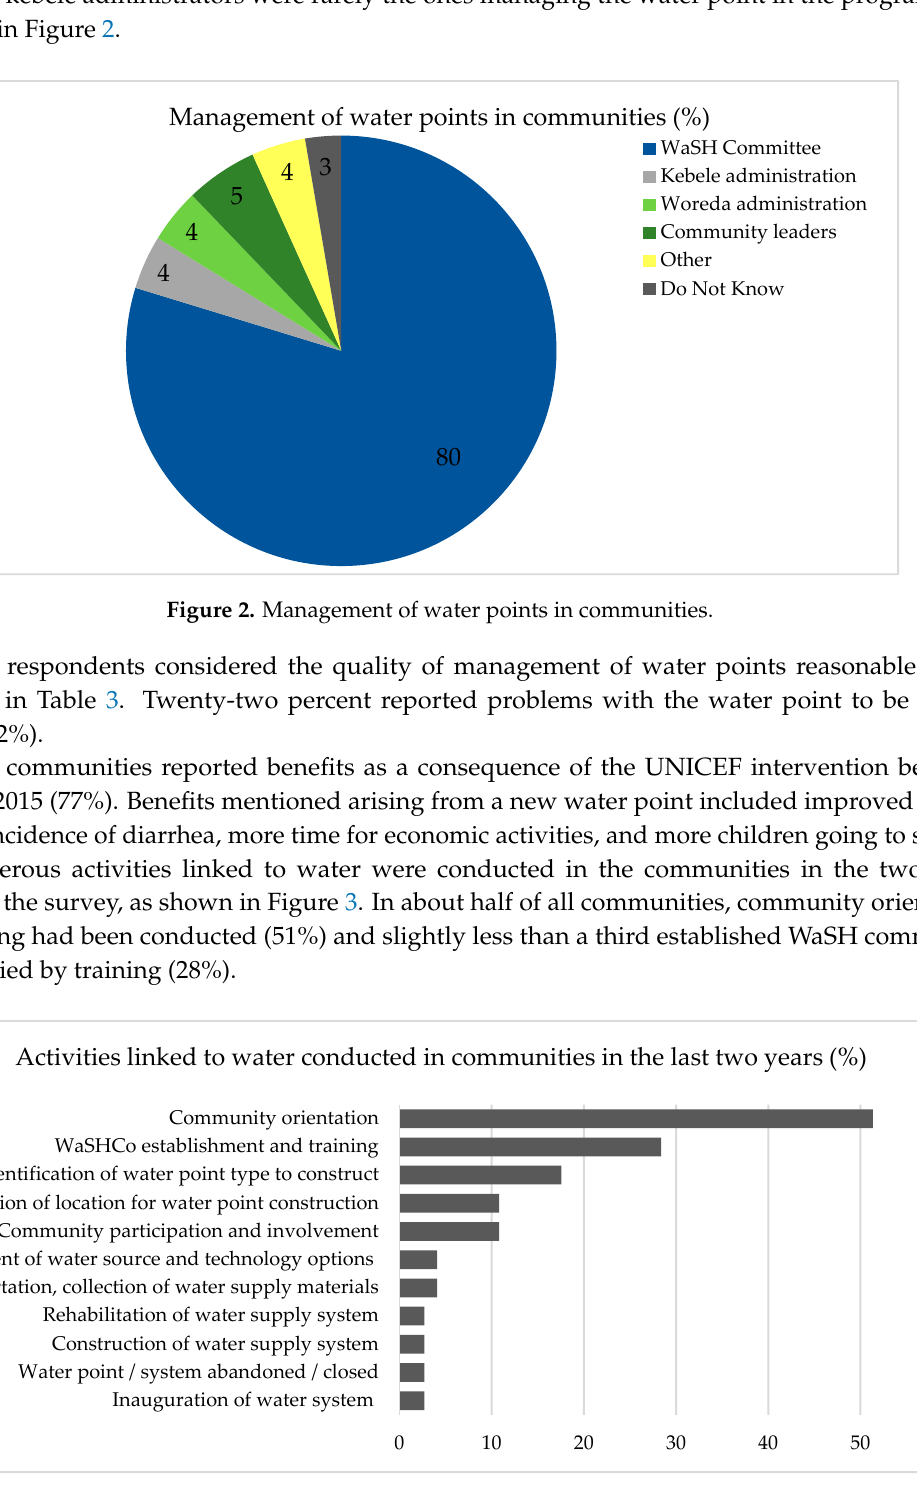
Figure 3. Activities linked to water in communities.